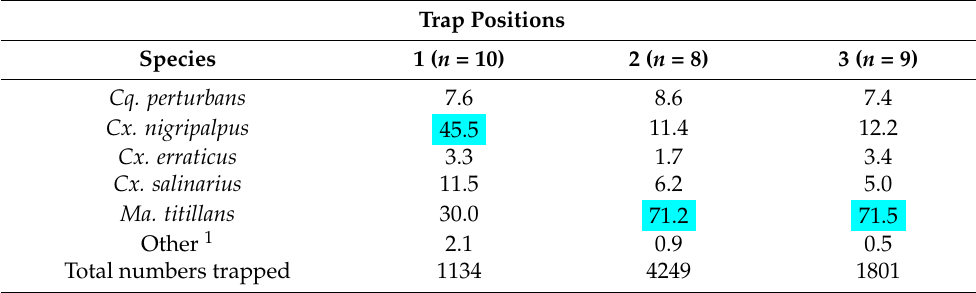
Table 4. Percentage and total number of mosquito species trapped at each CDC 1012 trap position during the location profile study conducted on 13 July–26 August 2004, at the UF Horse Teaching Unit, Gainesville, FL, USA. The highest percentage of species captured at each position is high- lighted.